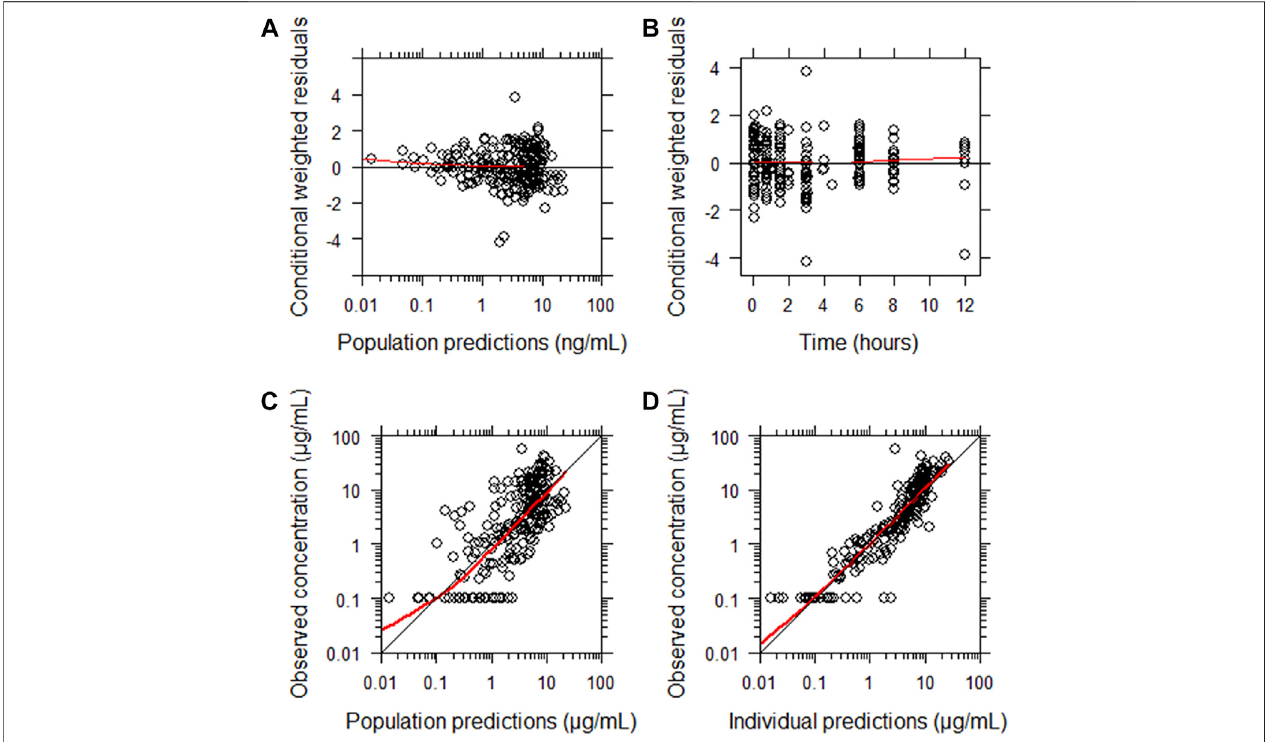
FIGURE 2 | Goodness-of- fi t of the fi nal population pharmacokinetic model describing meropenem. (A) Conditionally weighted residuals vs population predicted concentrations. (B) Conditionally weighted residuals vs time. (C) Observed plasma concentrations vs population predicted concentrations. (D) Observed plasma concentrations vs individually predicted concentrations. Solid red lines represent locally weighted least squares regressions. There is consistency around lines of unity and a lack of bias noted.